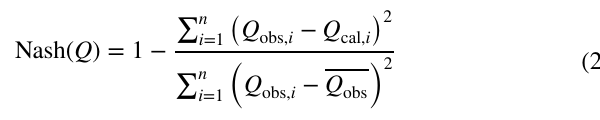
Table 2 Values of the parameters after calibration and performance of the Wadi Bechar watershed